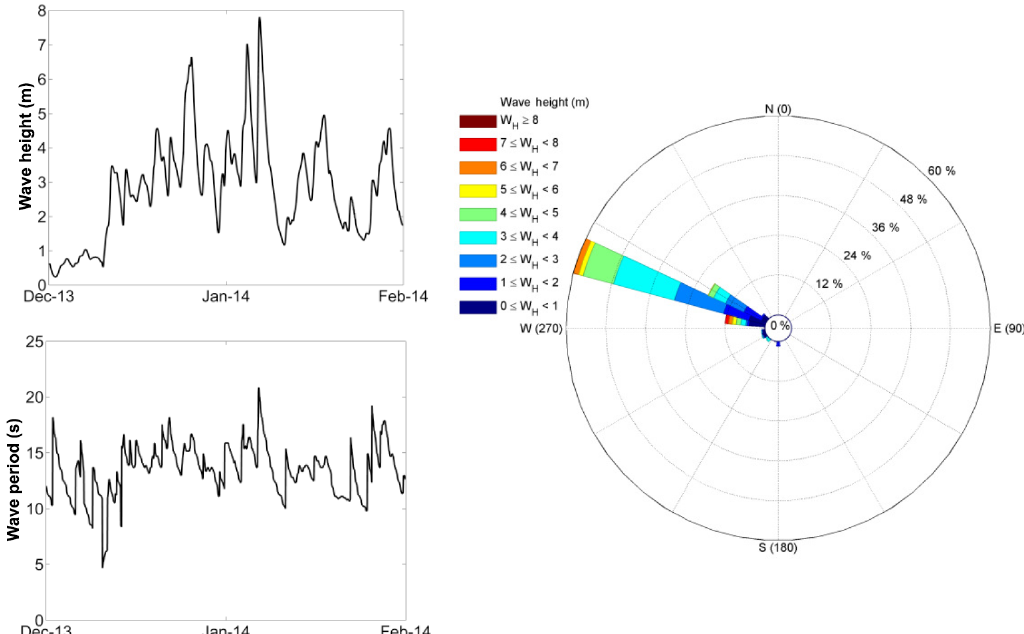
Figure 11. Wave conditions for the winter of 2013/2014 obtained from the Portuguese coast wave model in the location of the port of Lisbon wave